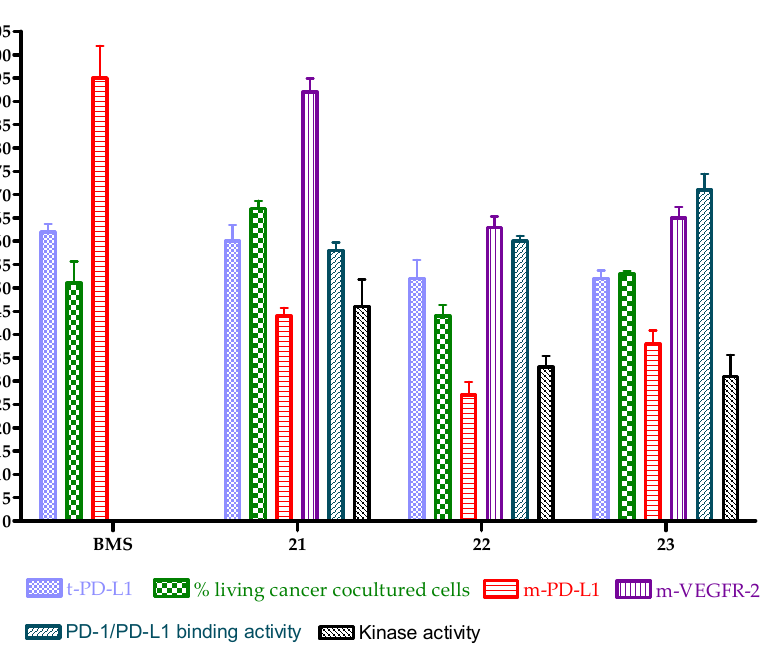
Figure 7. Summary of results obtained for the chloro derivatives 21 – 23 .